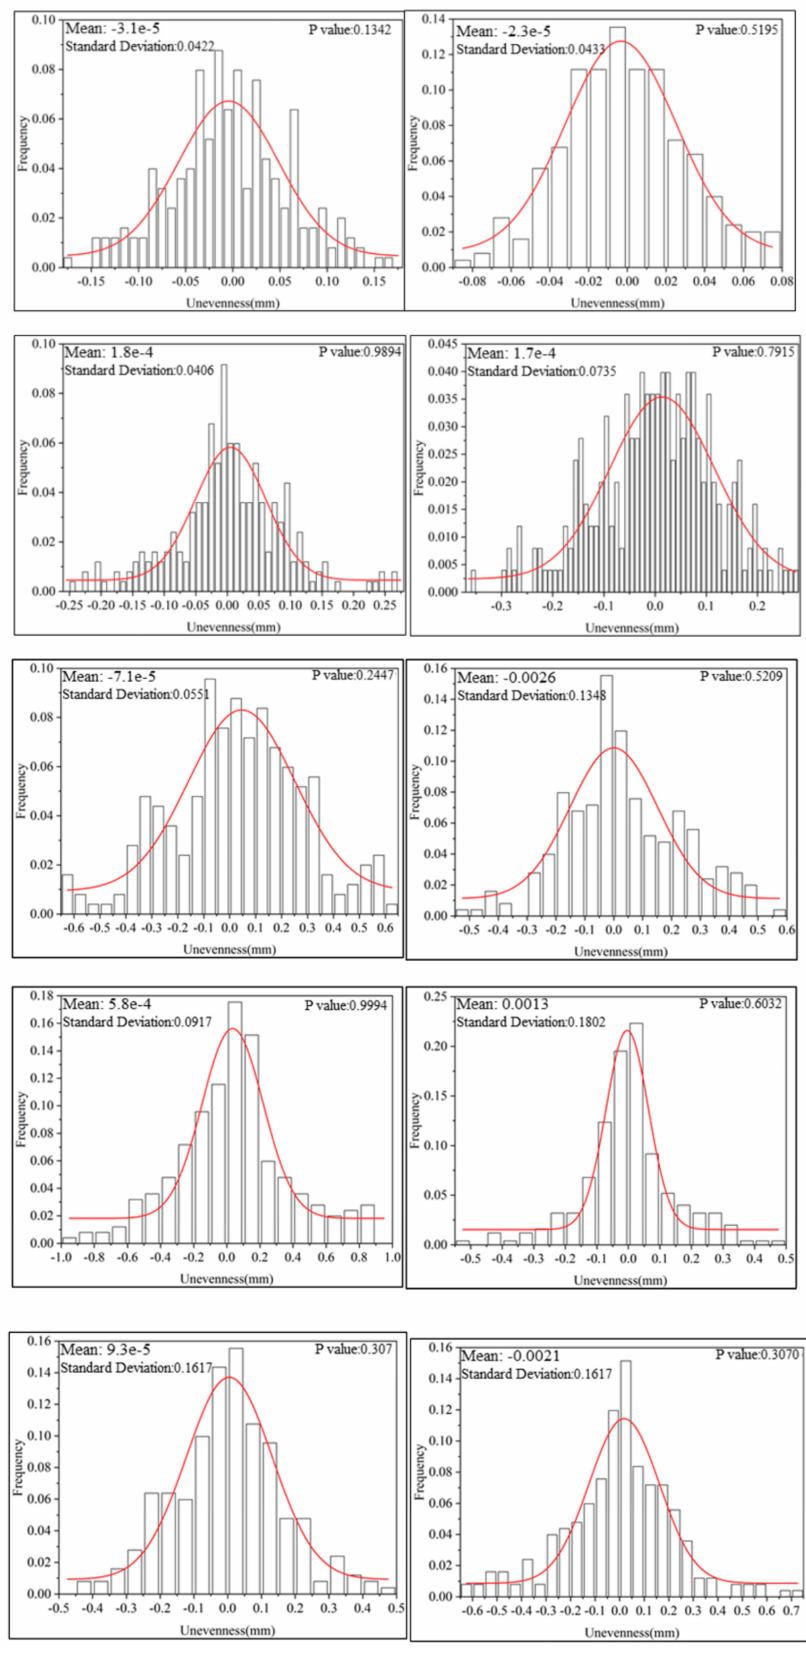
Figure 5. Histogram of the unevenness